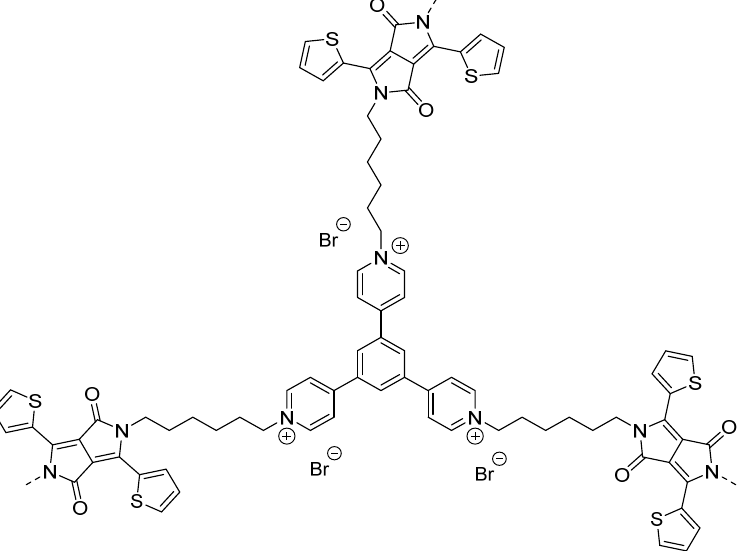
Figure 21. Structure of the hyperbranched polyelectrolyte active for sacrificial photocatalytic hydro- gen production [113].